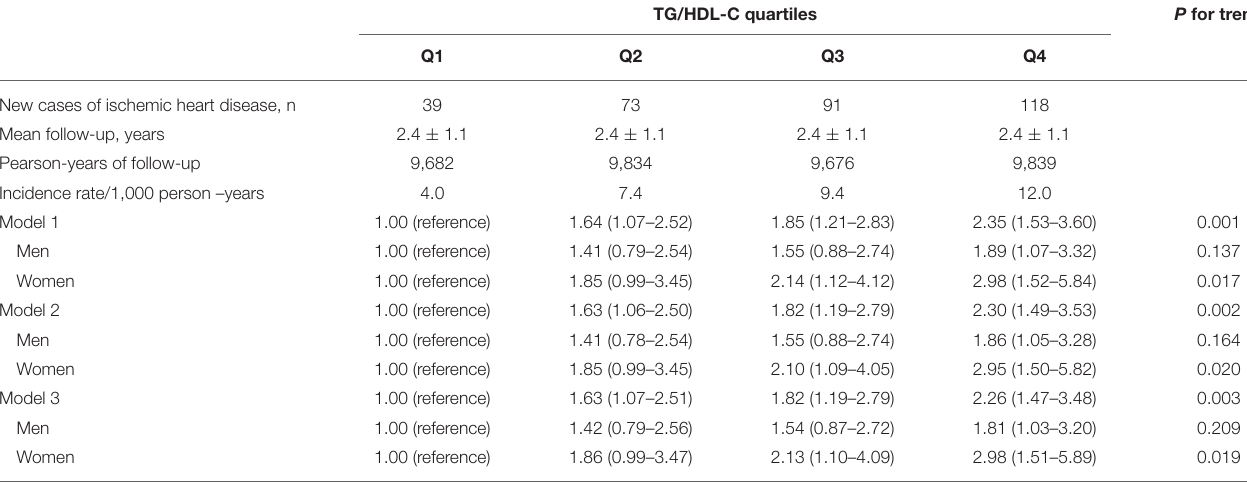
TABLE 4 | Hazard ratios and 95% confidence intervals for new-onset ischemic heart diseases according to TG/HDL-C